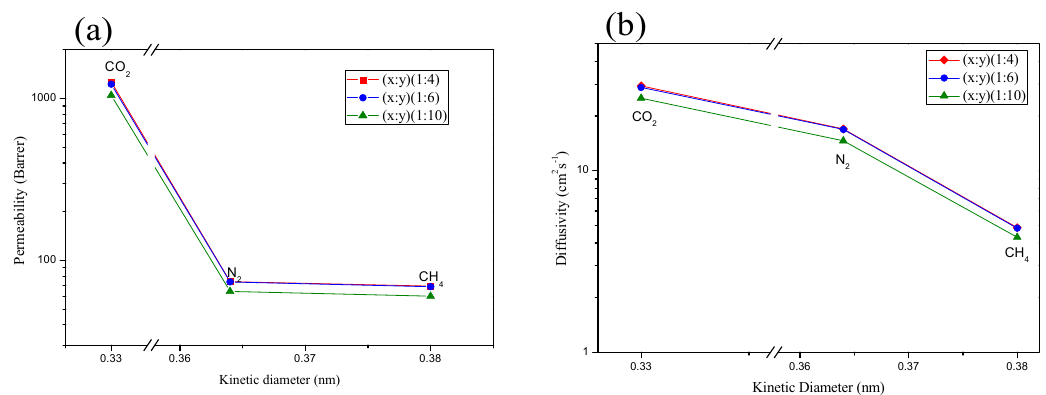
Figure 6. Gas permeability ( a ) and diffusivity ( b ) of the (PIM-PI)x-(6FDA-durene-PI)y copolymer membranes as a function of the kinetic diameter of the gas molecules.